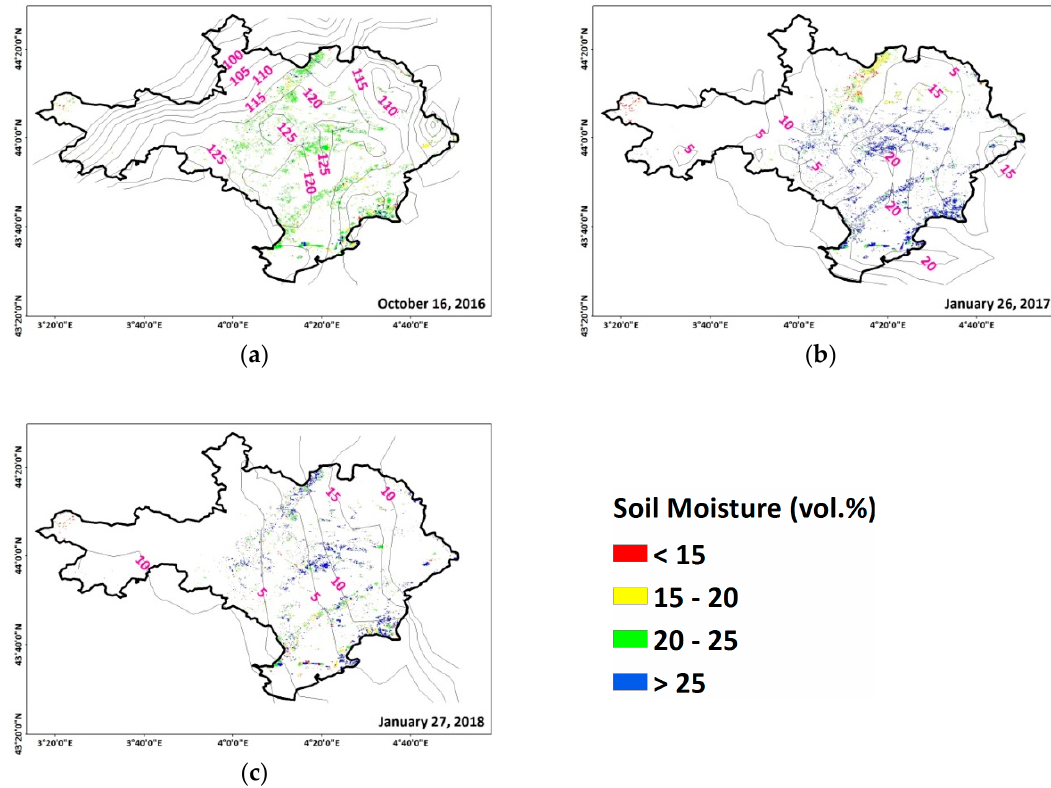
Figure 6. S1-derived SSM maps overlaid with GPM precipitation data. ( a ) 16 October 2016, ( b ) 26 January 2017, and ( c ) 27 January 2018. Contour lines represent precipitation amounts in mm.